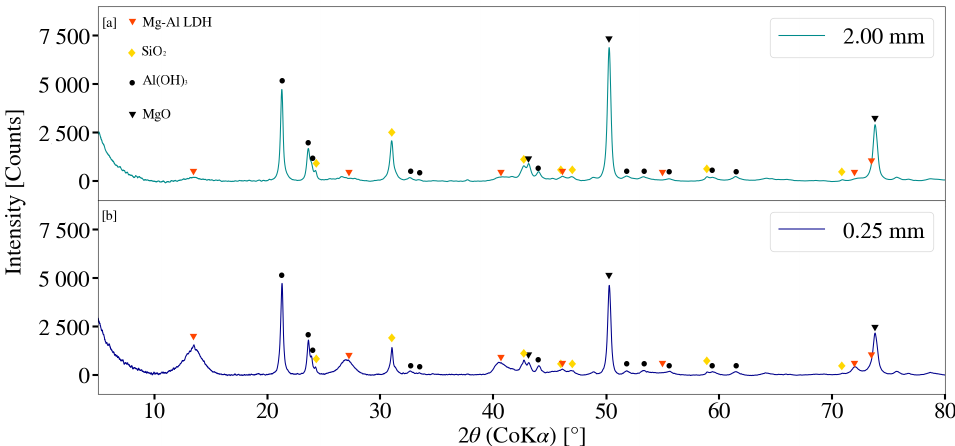
Figure 13. ( a ) X-ray diffraction pattern for Mg-Al LDH sample synthesised using milling media size of 2 mm (S2). ( b ) X-ray diffraction pattern for Mg-Al LDH sample synthesised using milling media size of 0.25 mm (S9). Milling parameters were set at a rotational speed of 2000 rpm, jacket water inlet temperature of 30 °C, retention time of 1 h and a solids loading of